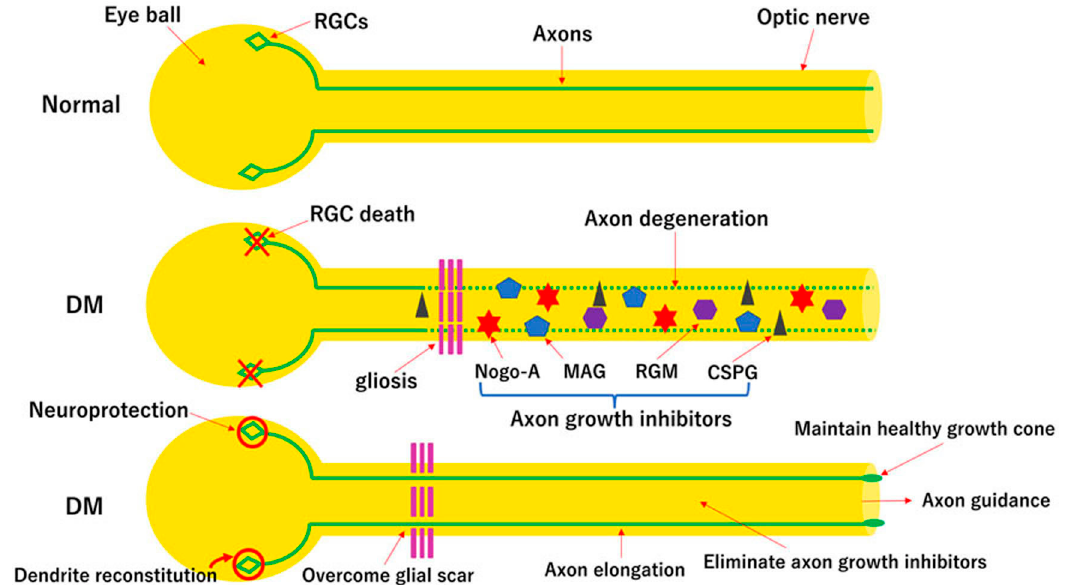
Figure 2. Scheme of multiple approaches for optic nerve regeneration in diabetic retina. RGCs are vulnerable under diabetic stress (the middle diagram). Therefore, in the early stage, RGCs must be protected. At the same time, however, axons are also degenerated. Thus, degenerated axons must also be regenerated. However, the glial environment of the central nervous system suppresses axonal regeneration because of astrogliosis and myelin debris such as Nogo-A or myelin-associated glycoprotein (MAG). For the success of optic nerve regeneration, the RGC death must be blocked and regenerating axons must overcome the glial scar barriers and elongate their axons in the middle of axon growth inhibitors. To overcome these barriers, the growth cone must be maintained in a healthy condition. Finally, regenerating axons must connect to the correct target cells in the brain by regulating axon guidance cues. DM, diabetes mellitus; RGM, repulsive guidance molecule; CSPG, chondroitin sulfate proteoglycan.